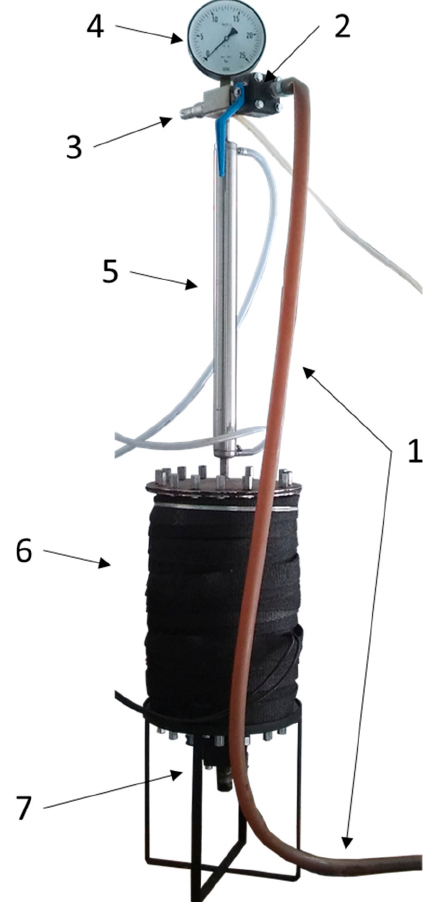
Figure 2. Reactor design. (1) exhaust torrgas pipe, (2) upper valve, (3) safety valve, (4) manometer, (5) cooler, (6) reactor chamber wrapped by heating mats and insulation, (7) lower valve.